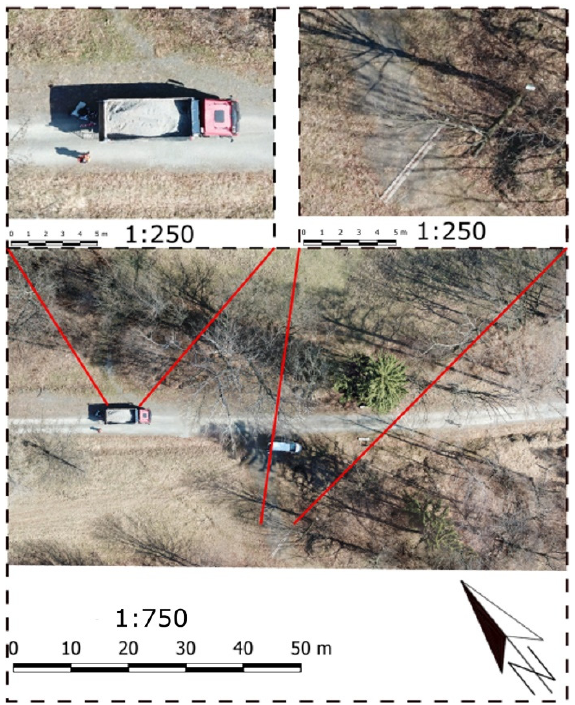
Figure 13. Measurements of engineering objects on a forest road in the Ś nie ż ka Forest District. The lower fragment of the orthophotomap: location of measurements with a VSS HMP PDG static plate, together with a counterweight and image of one of the open ‐ top culverts in the audited road. The red lines point at a zoom ‐ in on selected objects presented in the figure below (made by R. Borkowski).